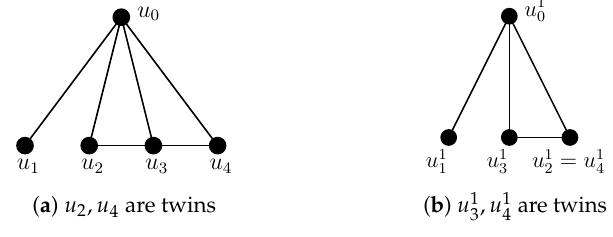
Figure 7. G 1 is not necessarily a twin-free